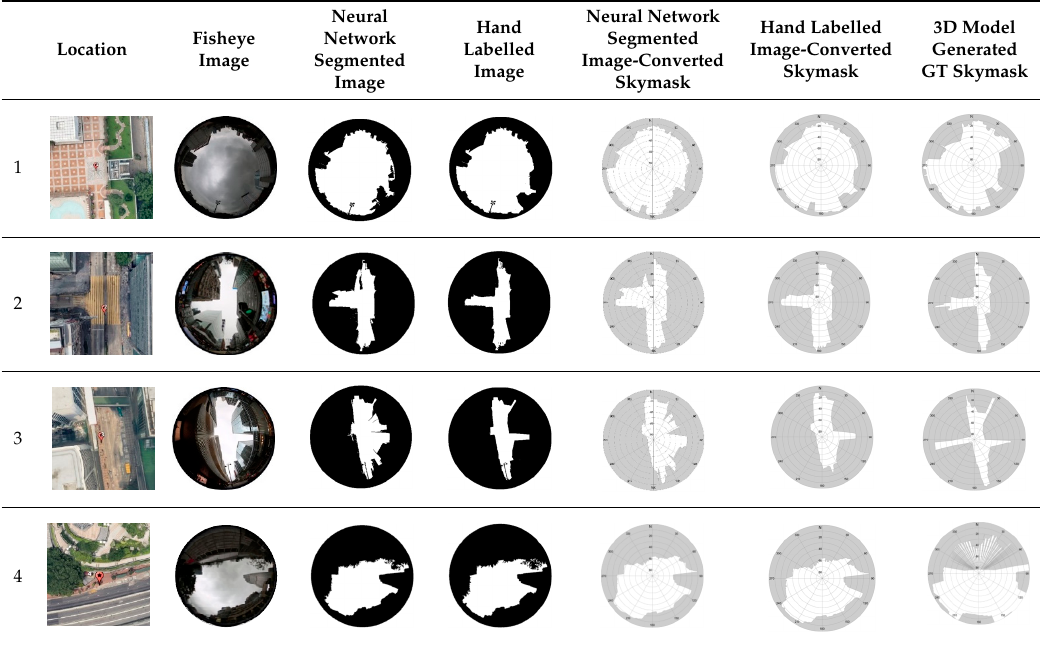
Table 2. Close view of experiment locations 1–4 and the comparison between neural network segmented Images, labelled Images, their respective skymasks, and GT skymasks.